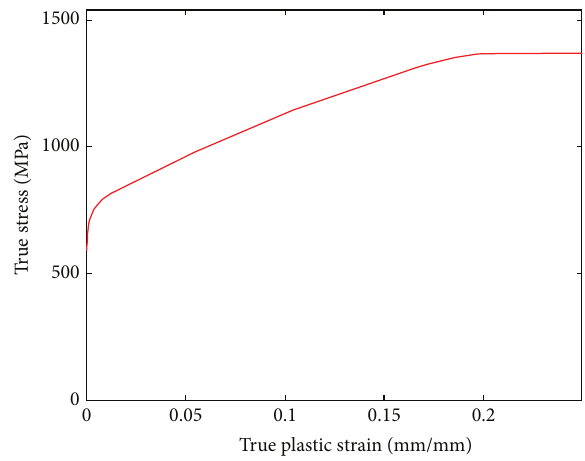
Figure 2: Material model for K-Monel